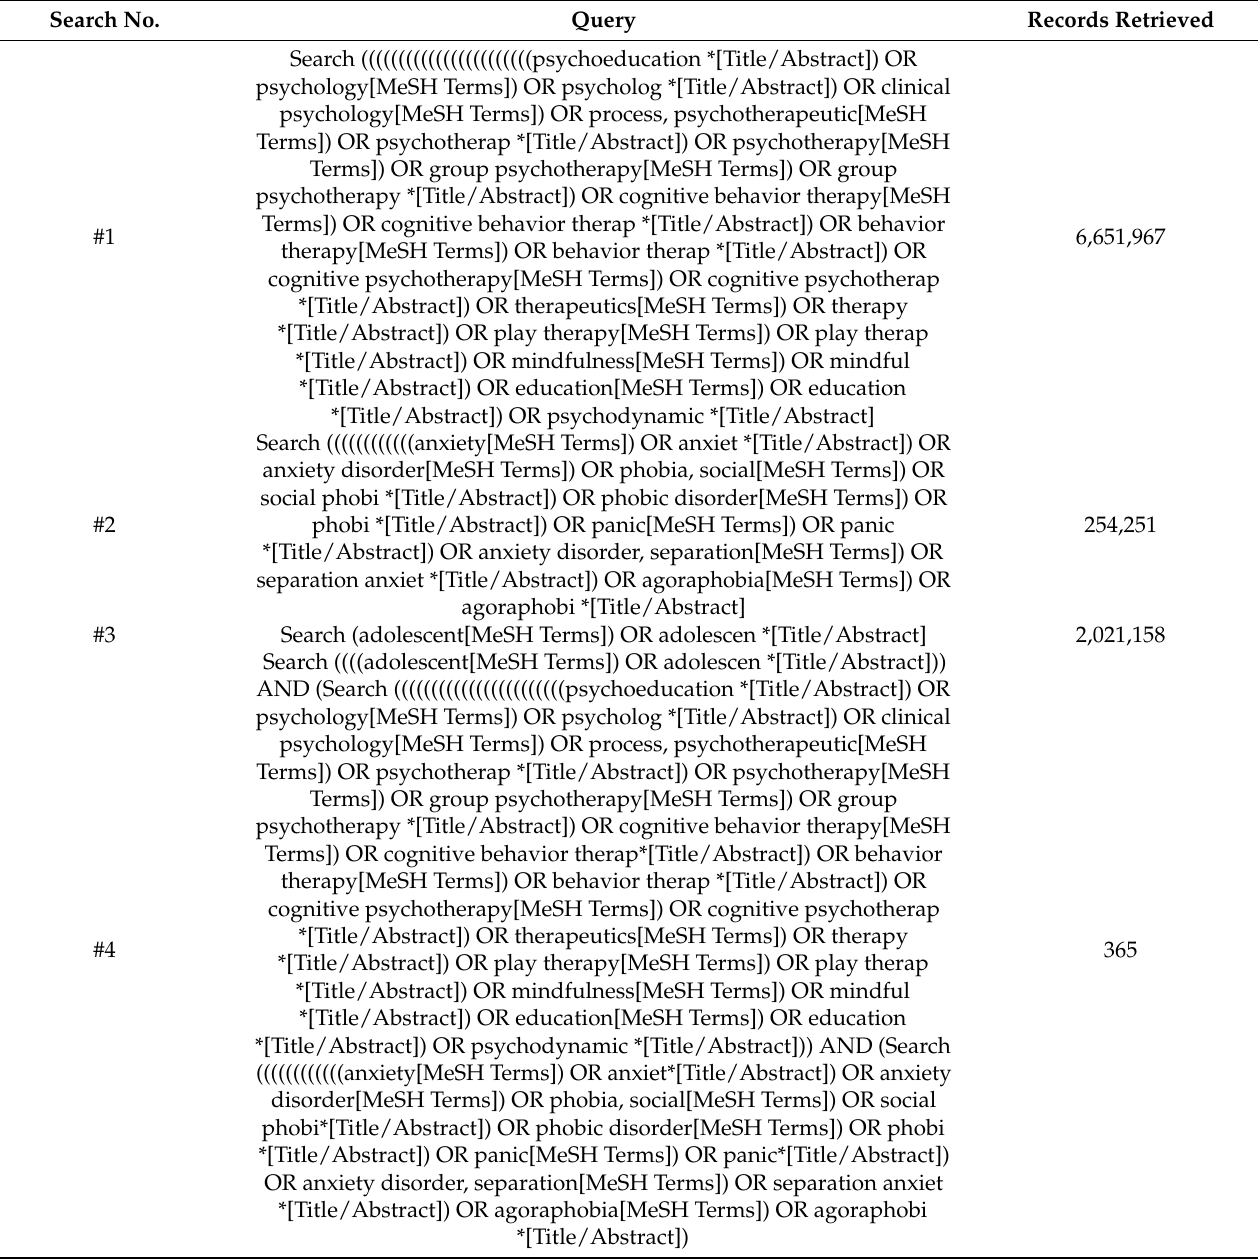
Table A1. Draft of search strategy to Medline (PubMed) 1 . Search